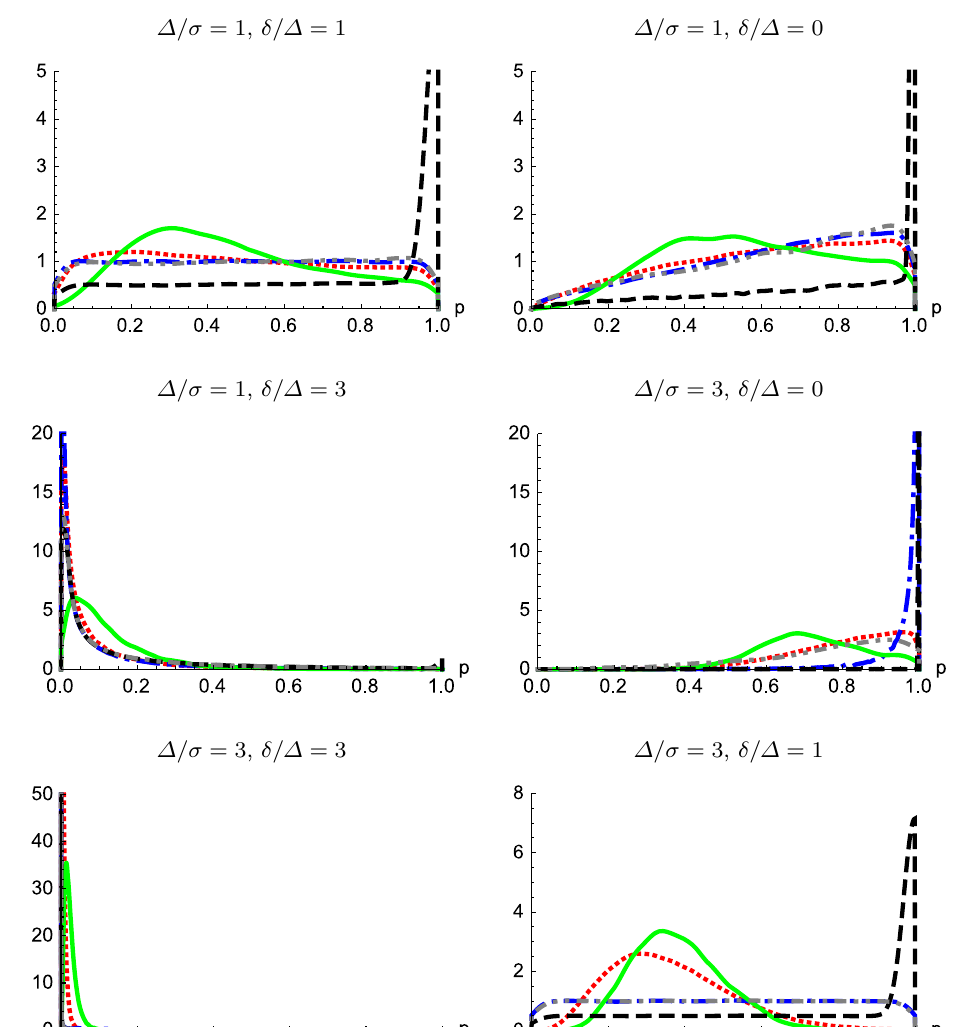
Fig. 6 Distribution of p value (for a fixed total number of events) for different true values δ/Δ and various relative sizes of statistical and theoretical uncertainties Δ/σ . The following approaches are shown: nG ( dotted , red ), Rfit or 1-external ( dashed , black ), fixed 1-nuisance ( dotted-dashed , blue ), adaptive nuisance ( solid , green ). Since the 1-